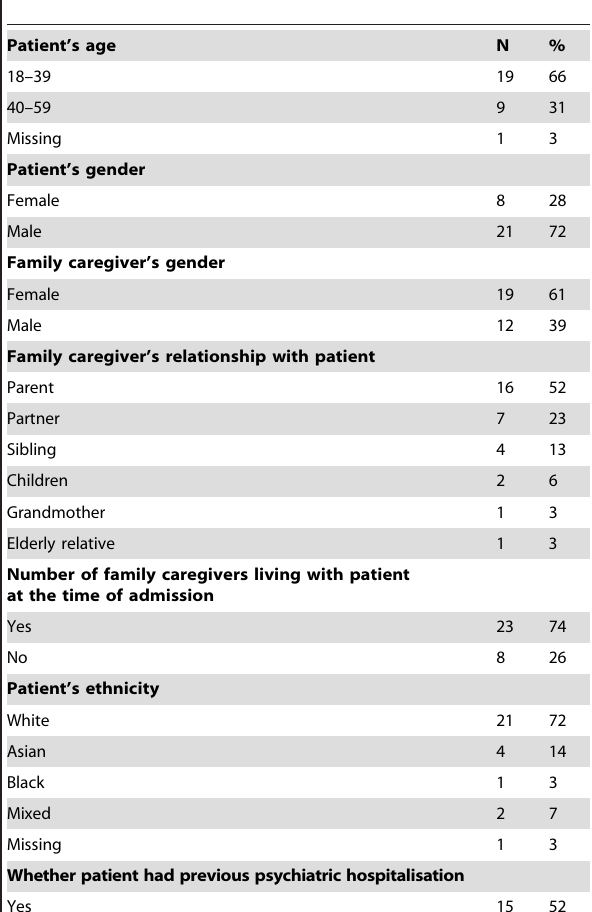
Table 2. Participant’s